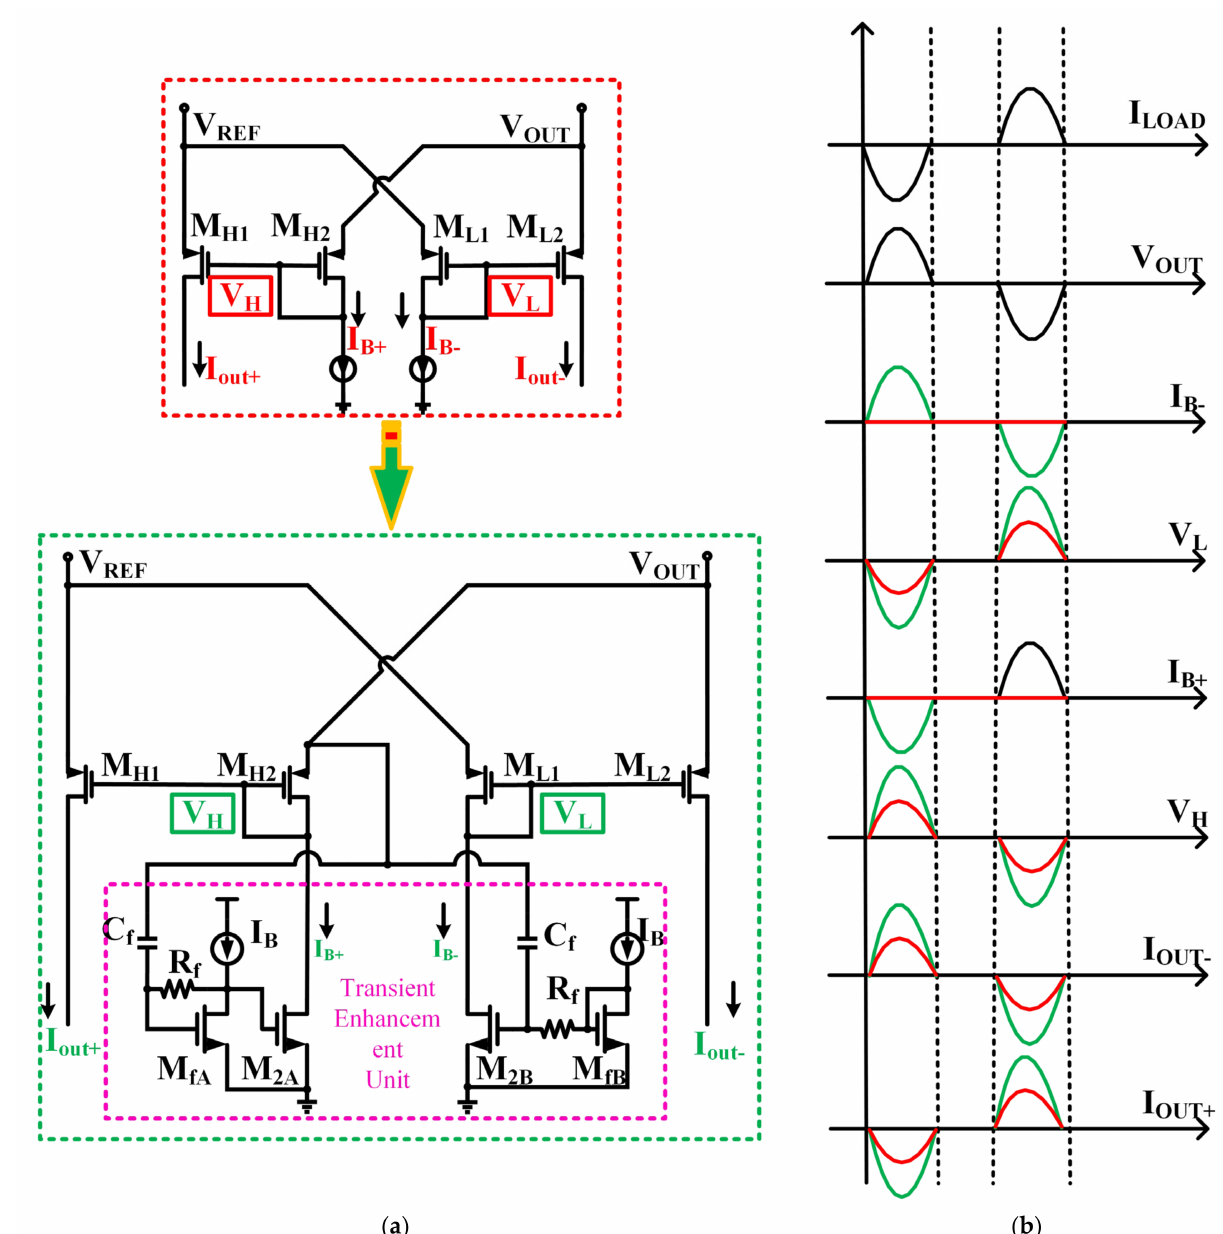
Figure 2. ( a ) Gm cells with the constant tail current source in [24] and Gm cells with the proposed TEU; ( b ) Operational principle comparison of the two structures in ( a